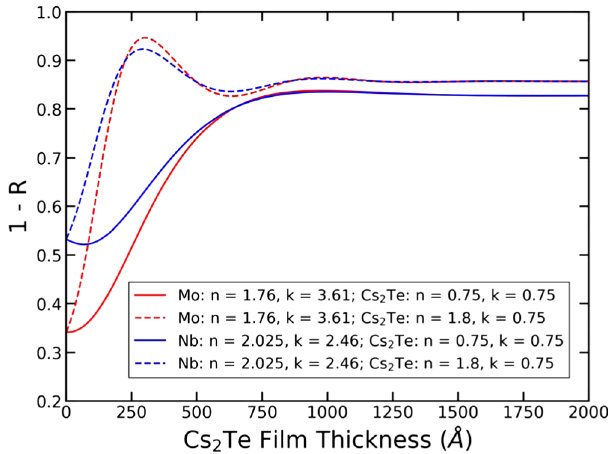
FIG. 3. Dependence of the transmission, 1 - R , vs film thickness determined from the Fresnel equations and optical constants of Nb, Mo and Cs 2 Te shown in the